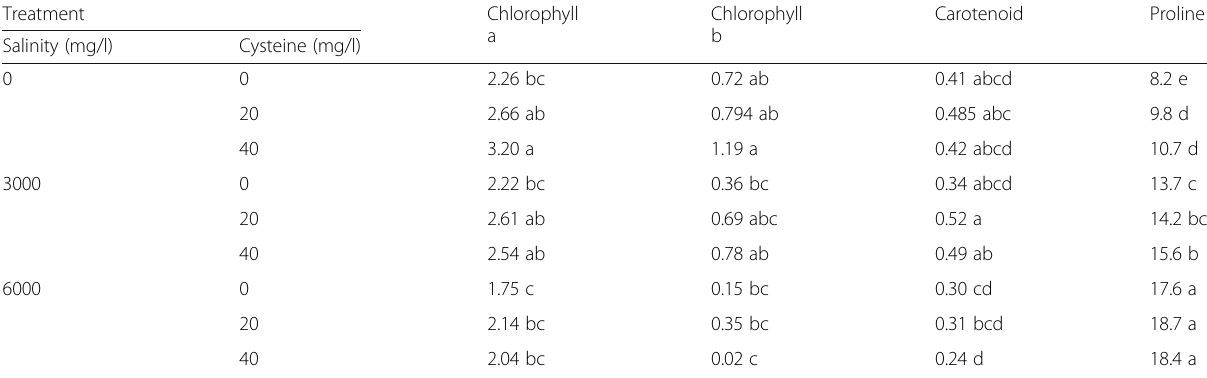
Table 2 Effect of cysteine (0, 20, and 40 mg/l) on photosynthetic pigments (mg/g fresh weight) and proline content (mg/100 g dry weight) of soybean leaf tissues irrigated with saline water (0, 3000, and 6000 mg/l). Results are means of two successive